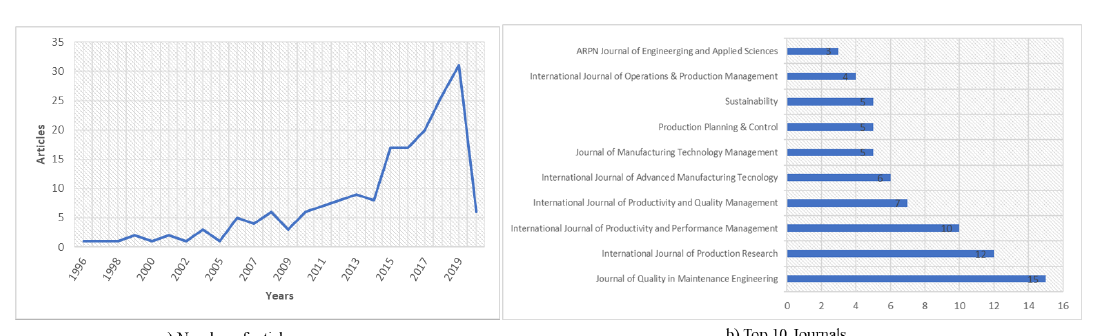
Figure 2. Basic data analysis of ( a ) number of articles per year and ( b ) Top 10 journals.